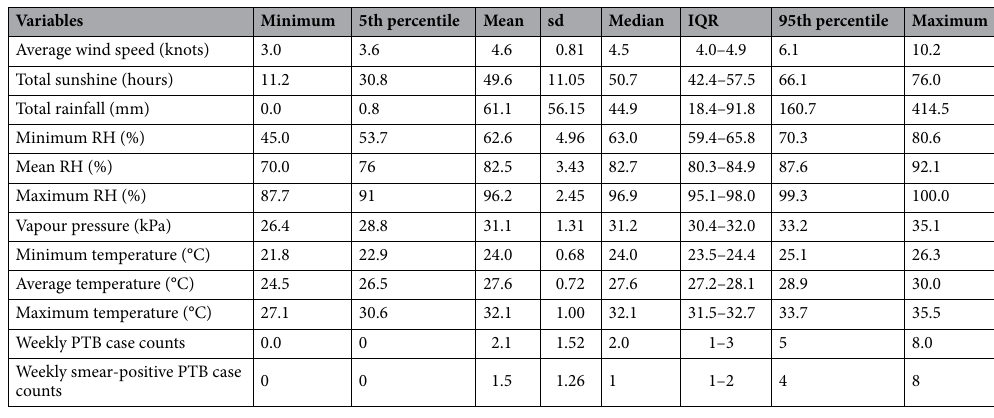
Table 1. Summary values for all climate variables and PTB case counts, Brunei